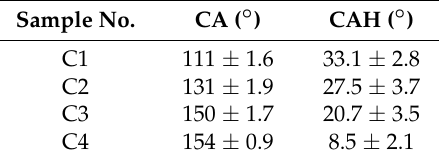
Table 1. Static contact angle (CA) and contact angle hysteresis (CAH) of the coating samples. Sample